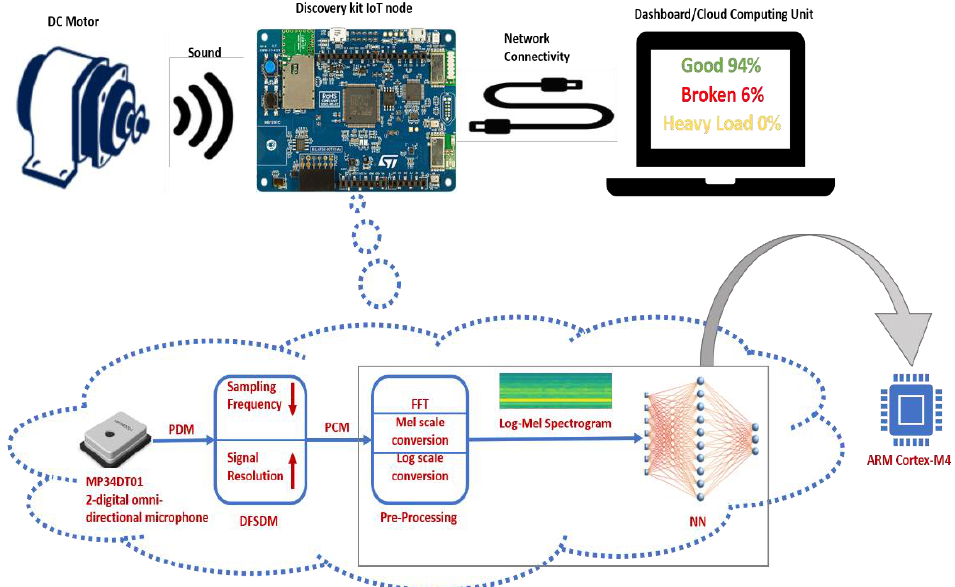
Figure 3. Architecture and block diagram for the DC motor’s operational state recognition via the EDGE-AI node.